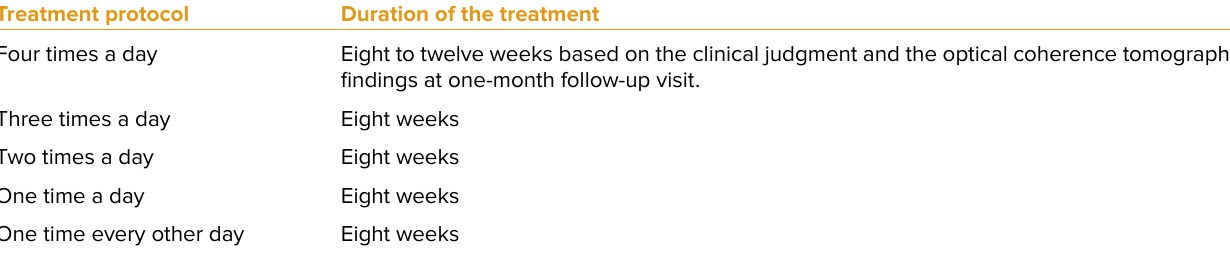
Table 1. Treatment protocol Treatment protocol Duration of the treatment Eight to twelve weeks based on the clinical judgment and the optical coherence tomography findings at one-month follow-up